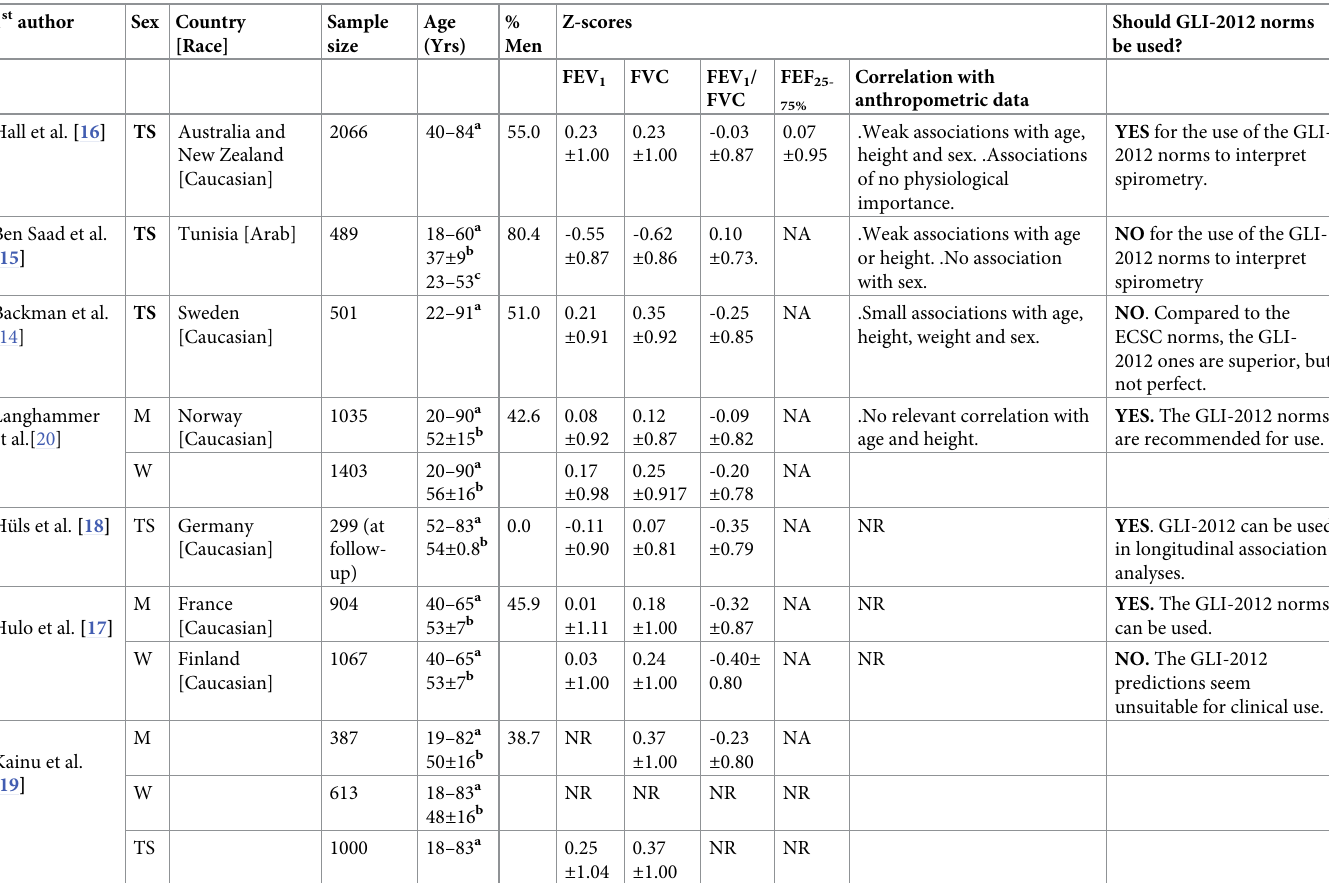
Table 4. Main characteristics and results of some similar studies including “healthy” “non-smoker” adults.